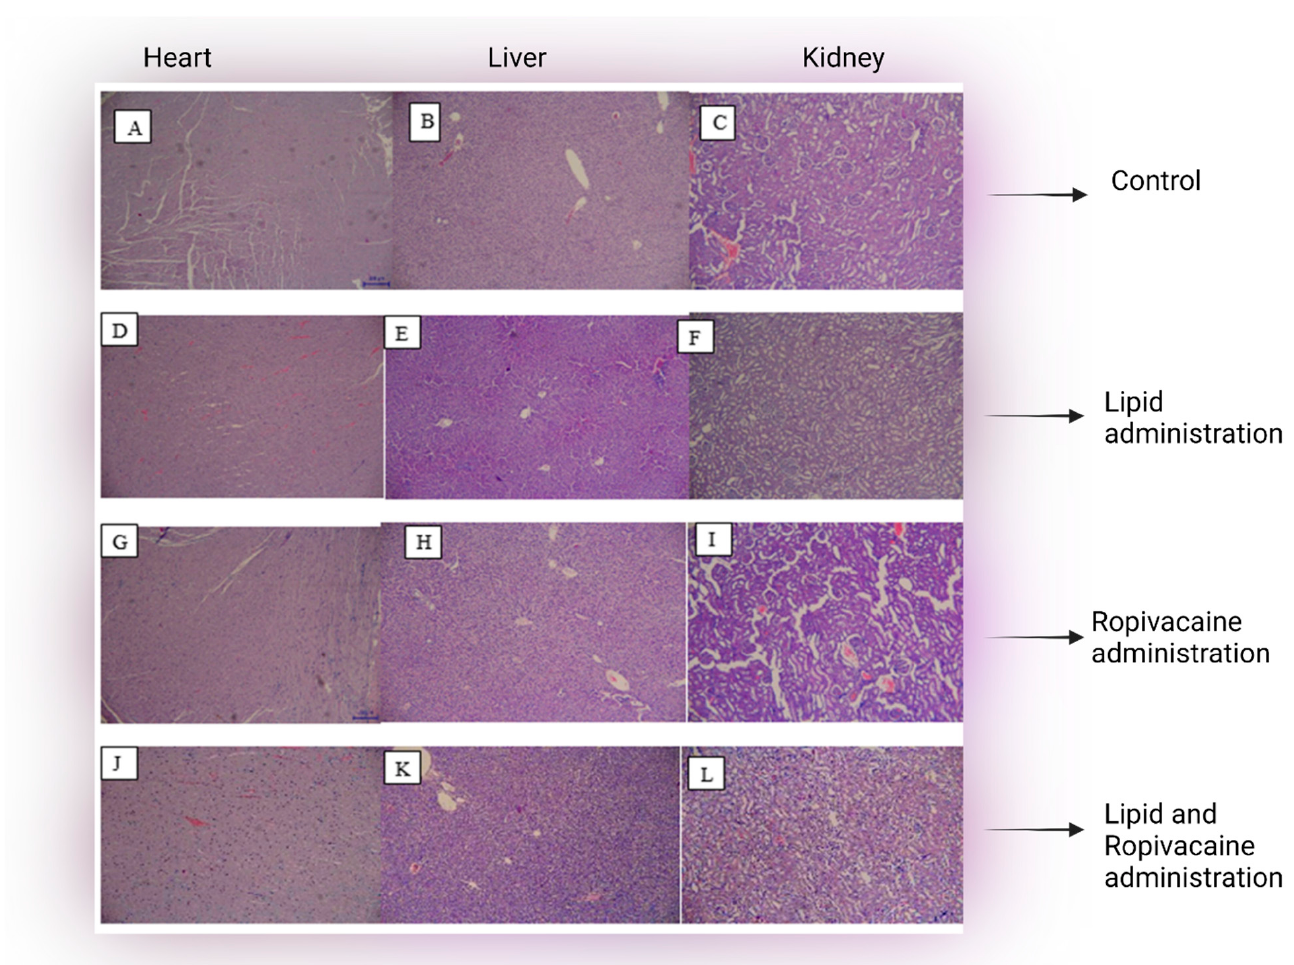
Figure 2. Administration of lipid emulsion prior to Ropivacaine (L + A) does not prove to induce relative change of heart rate and QRS complex duration in rats exposed to intravenous Ropivacaine only (A).